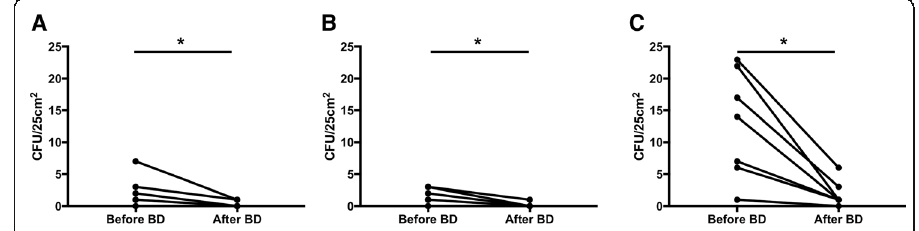
Fig. 3 The importance of an adequate biodecontamination on microbiological qualification. Microbiological qualification results on 3 areas of interest: the carousel with ISO4.8 specifications ( a ), the reservoir surface ( b ) and the gloves ( c ) both with ISO7 specifications, before and after biodecontamination (BD). * P < 0.05, n = 7; two-tailed Wilcoxon matched-pairs signed rank test.